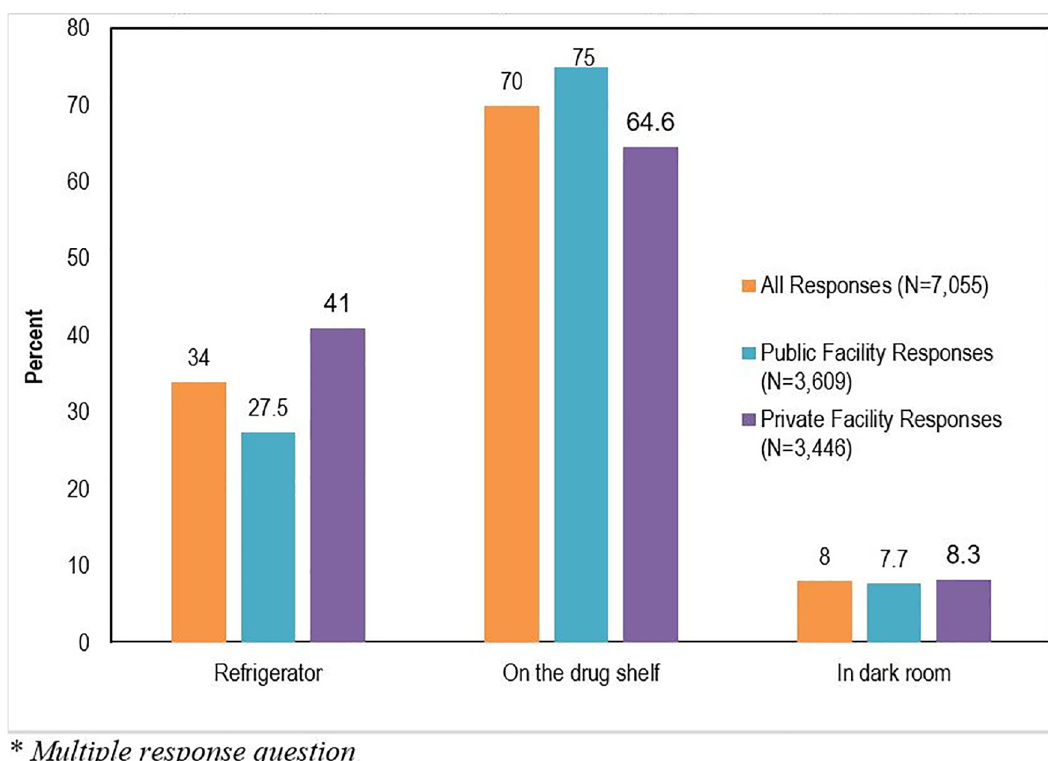
Fig 1. Respondents’ � oxytocin storage practices by facility type.